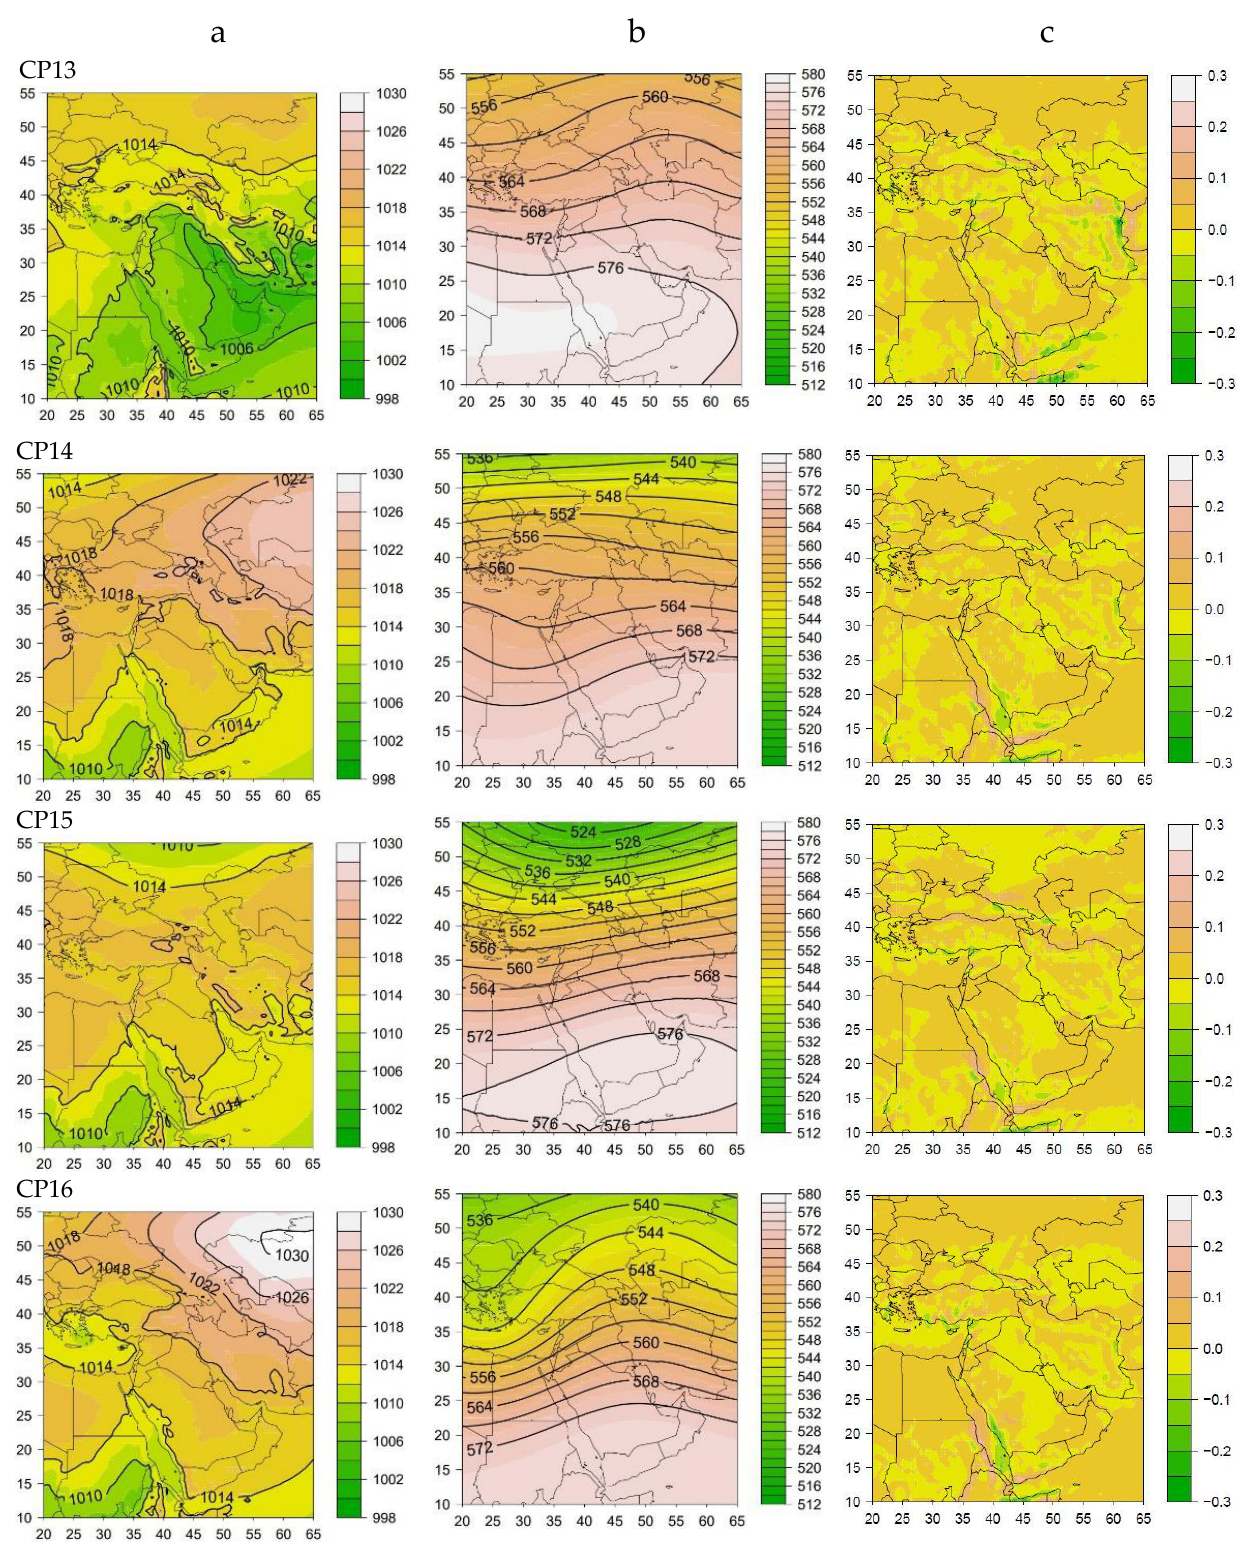
Figure 5. As in Figure 2, for patterns 13 – 16.